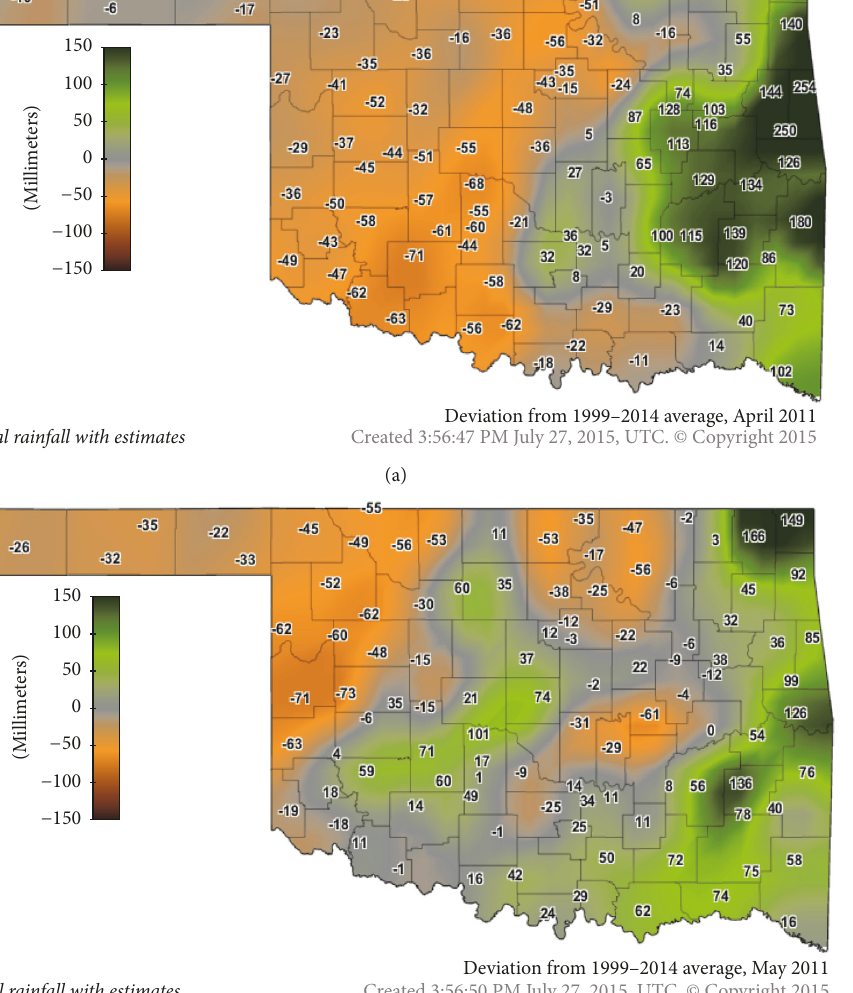
Figure 4: Map showing the monthly deviations from average total rainfall over the state of Oklahoma for April (a) and May (b) 2011, using measurements obtained from the Oklahoma Mesonet. Values display the actual deviation at each station and color filled gradient was created using a four-pass Barnes technique using the values at each station. Deviations are calculated from the 1999–2014 average during each